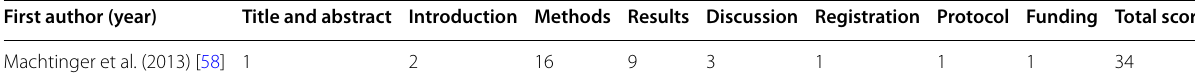
Table 6 Quality assessment of clinical trial study (according to Juni’s